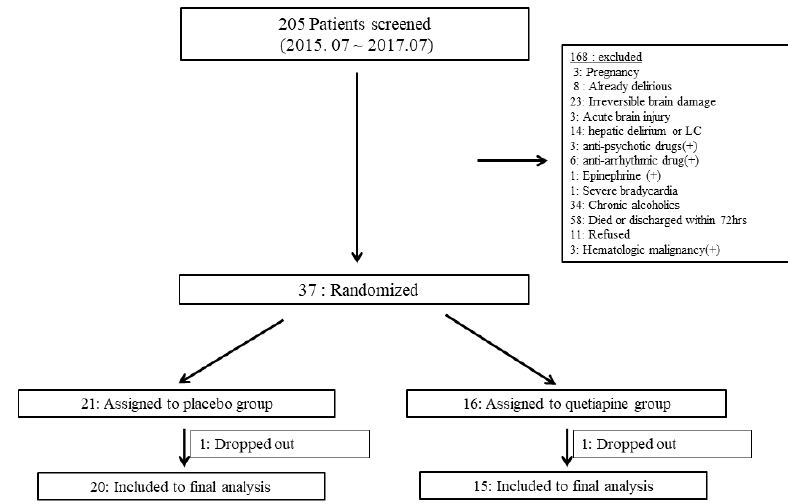
Figure 2. Enrolment and randomization of the study participants.